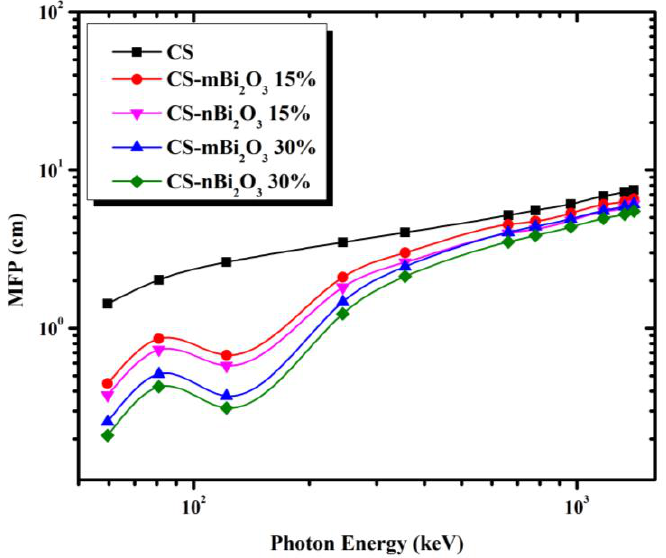
Figure 7. Variation of the mean free path (MFP) with the photon energy.